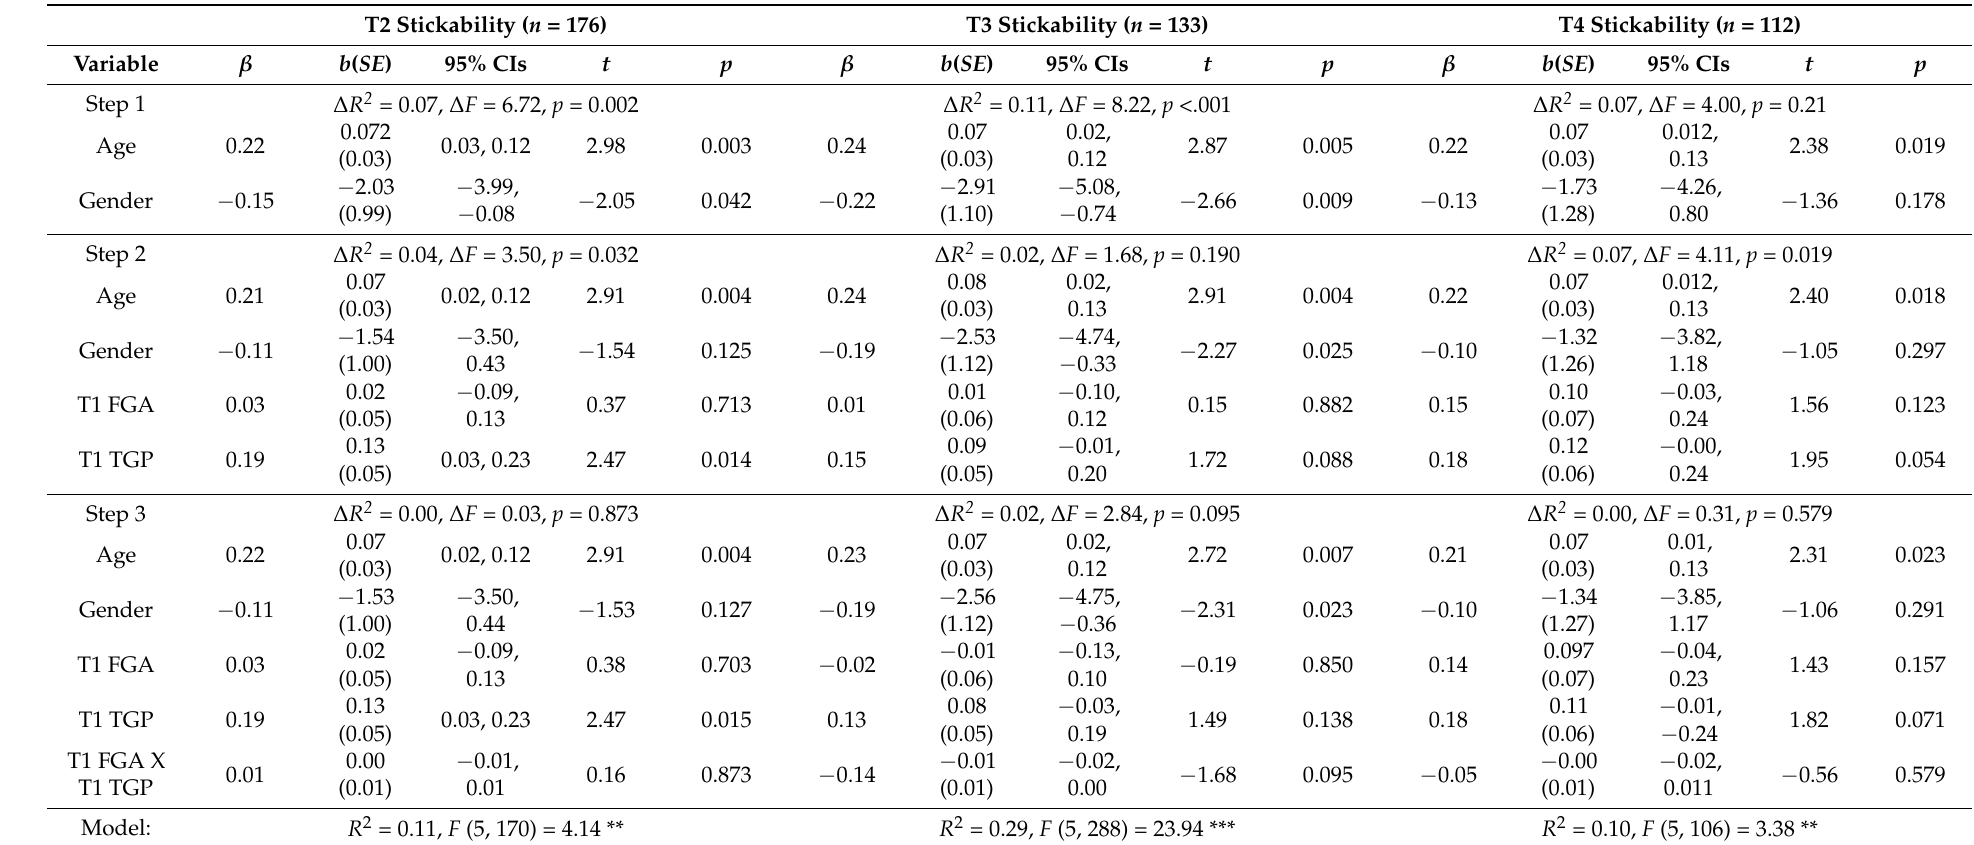
Table 3. Tenacious goal pursuit and flexible goal adjustment as predictors of exercise resolution stickability from Time 2 to Time